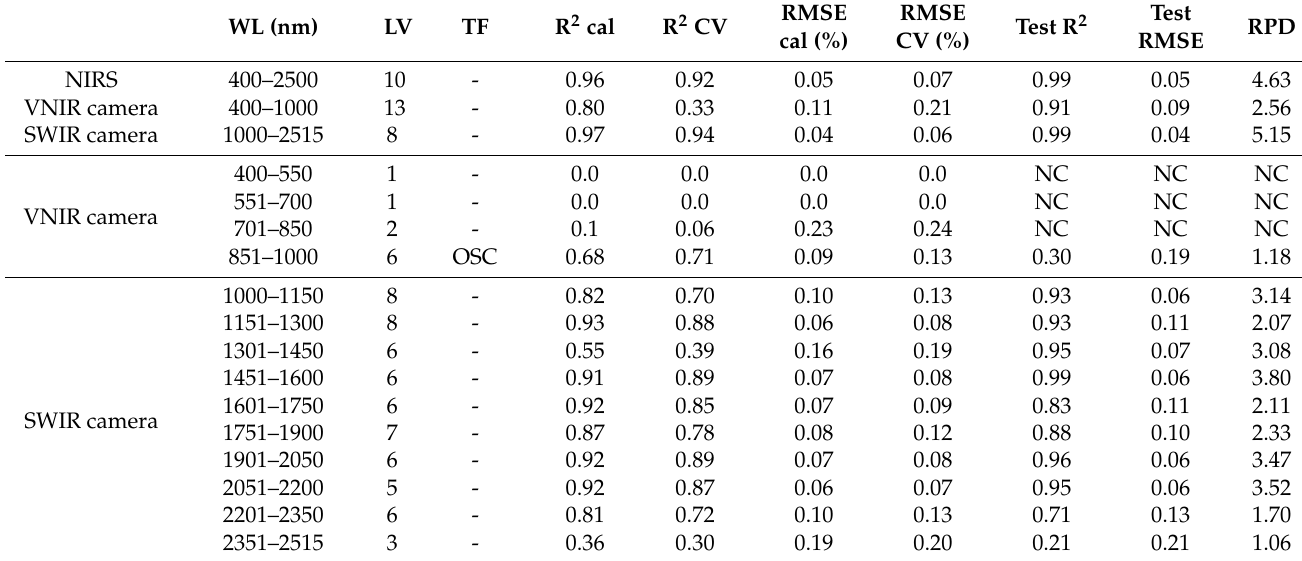
Table 3. Attributes of the PLSR models developed for predicting nitrogen (N) in the calibration and test